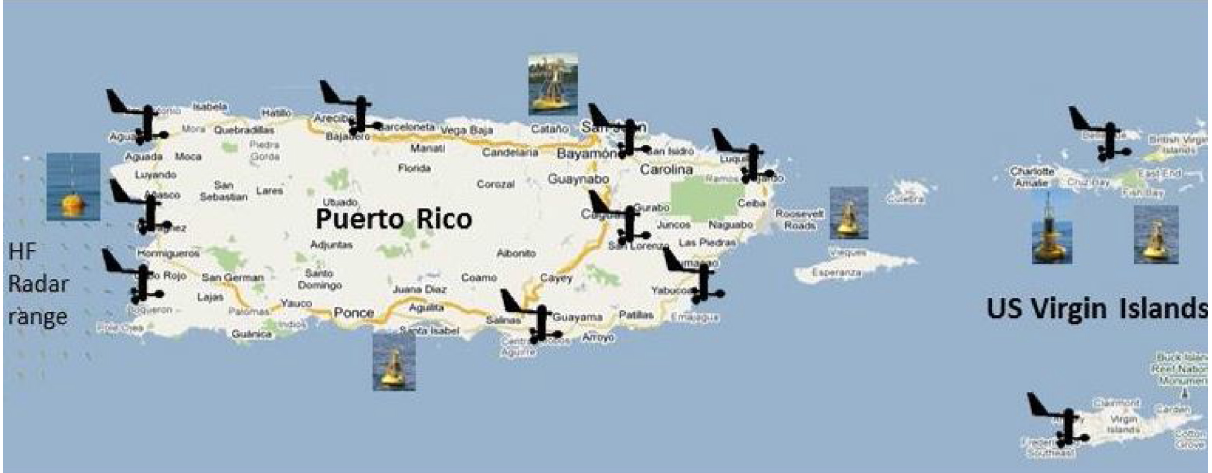
Fig. 7. CariCOOS weather stations and buoys, Puerto Rico and USVI. In the USVI the two anemometer symbols actually represent a total of six weather stations (map modified from CariCOOS web page,